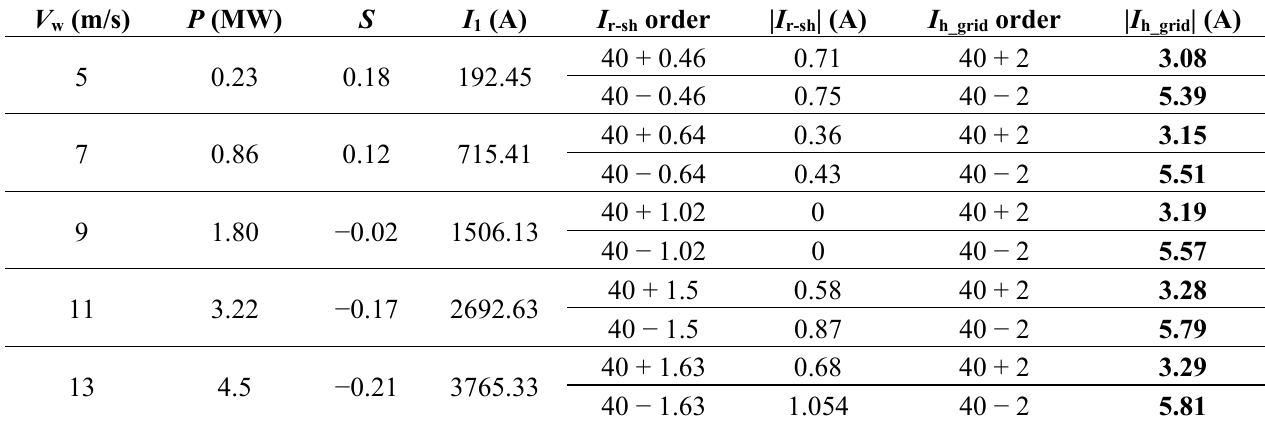
Table 5. The comparison of two kinds of switching harmonics with different